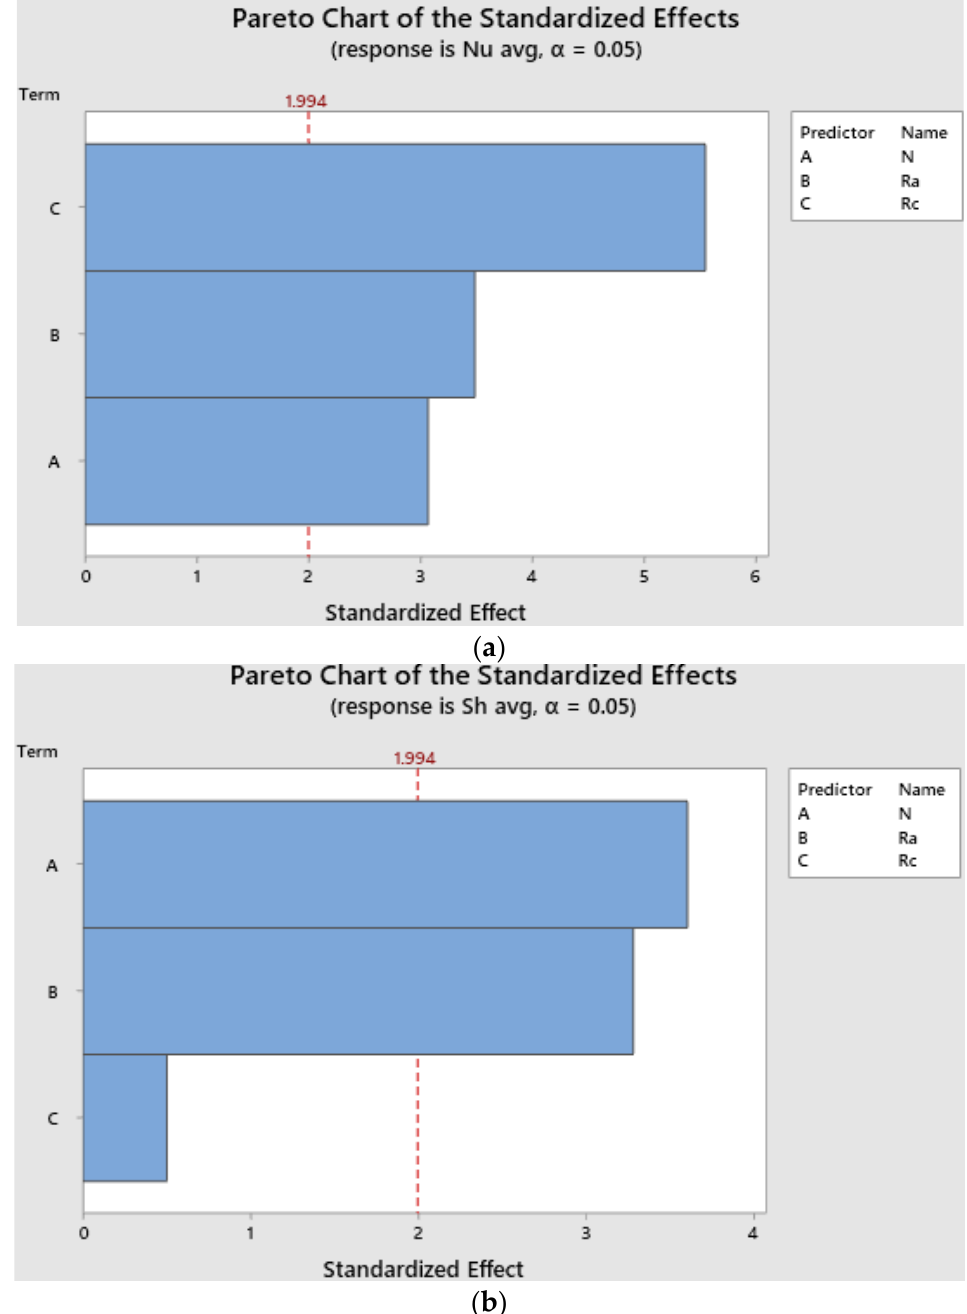
Figure 11. Pareto chart of the standardised effects ( a ) for Nu av and ( b ) for Sh av . In order to determine the optimised solution for this current study, Figure 12 represents the response optimisation. The recommended solution is given in Table 3.